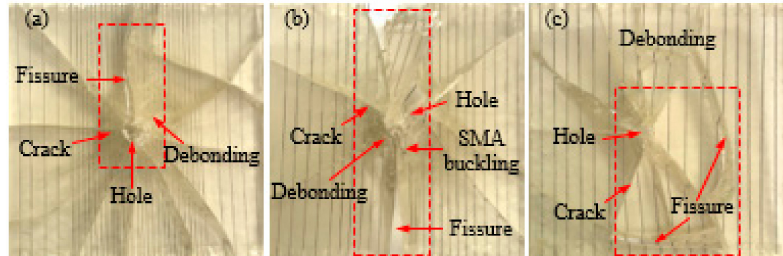
Figure 10. The failure modes diagrams of specimens with different SMA layup spacing values and diameters under 14 J of energy: ( a – c ) indicate the SMA reinforced resin-matrix test specimens with SMA diameters of 0.3, 0.4, 0.5 mm, respectively, and SMA layup spacing of 2, 3.7, 6 mm,